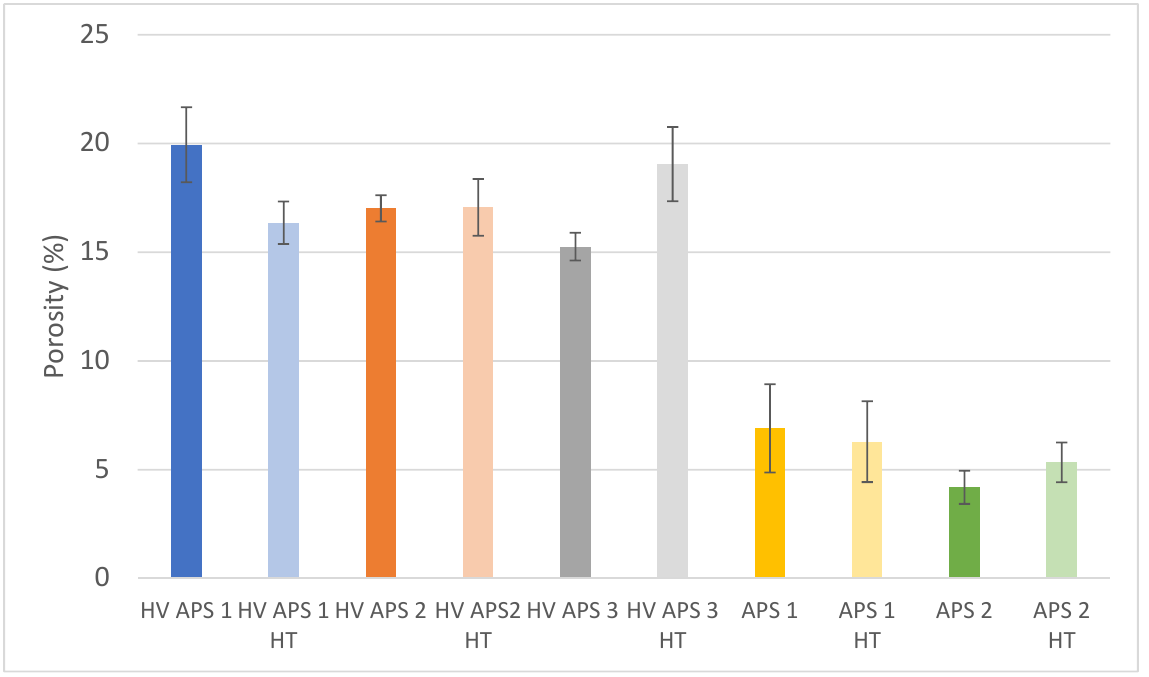
Figure 3. Porosity levels of the different coatings (see Table 1) in the as-sprayed state and after heat treatment (HT, 1300 °C, 100 h).